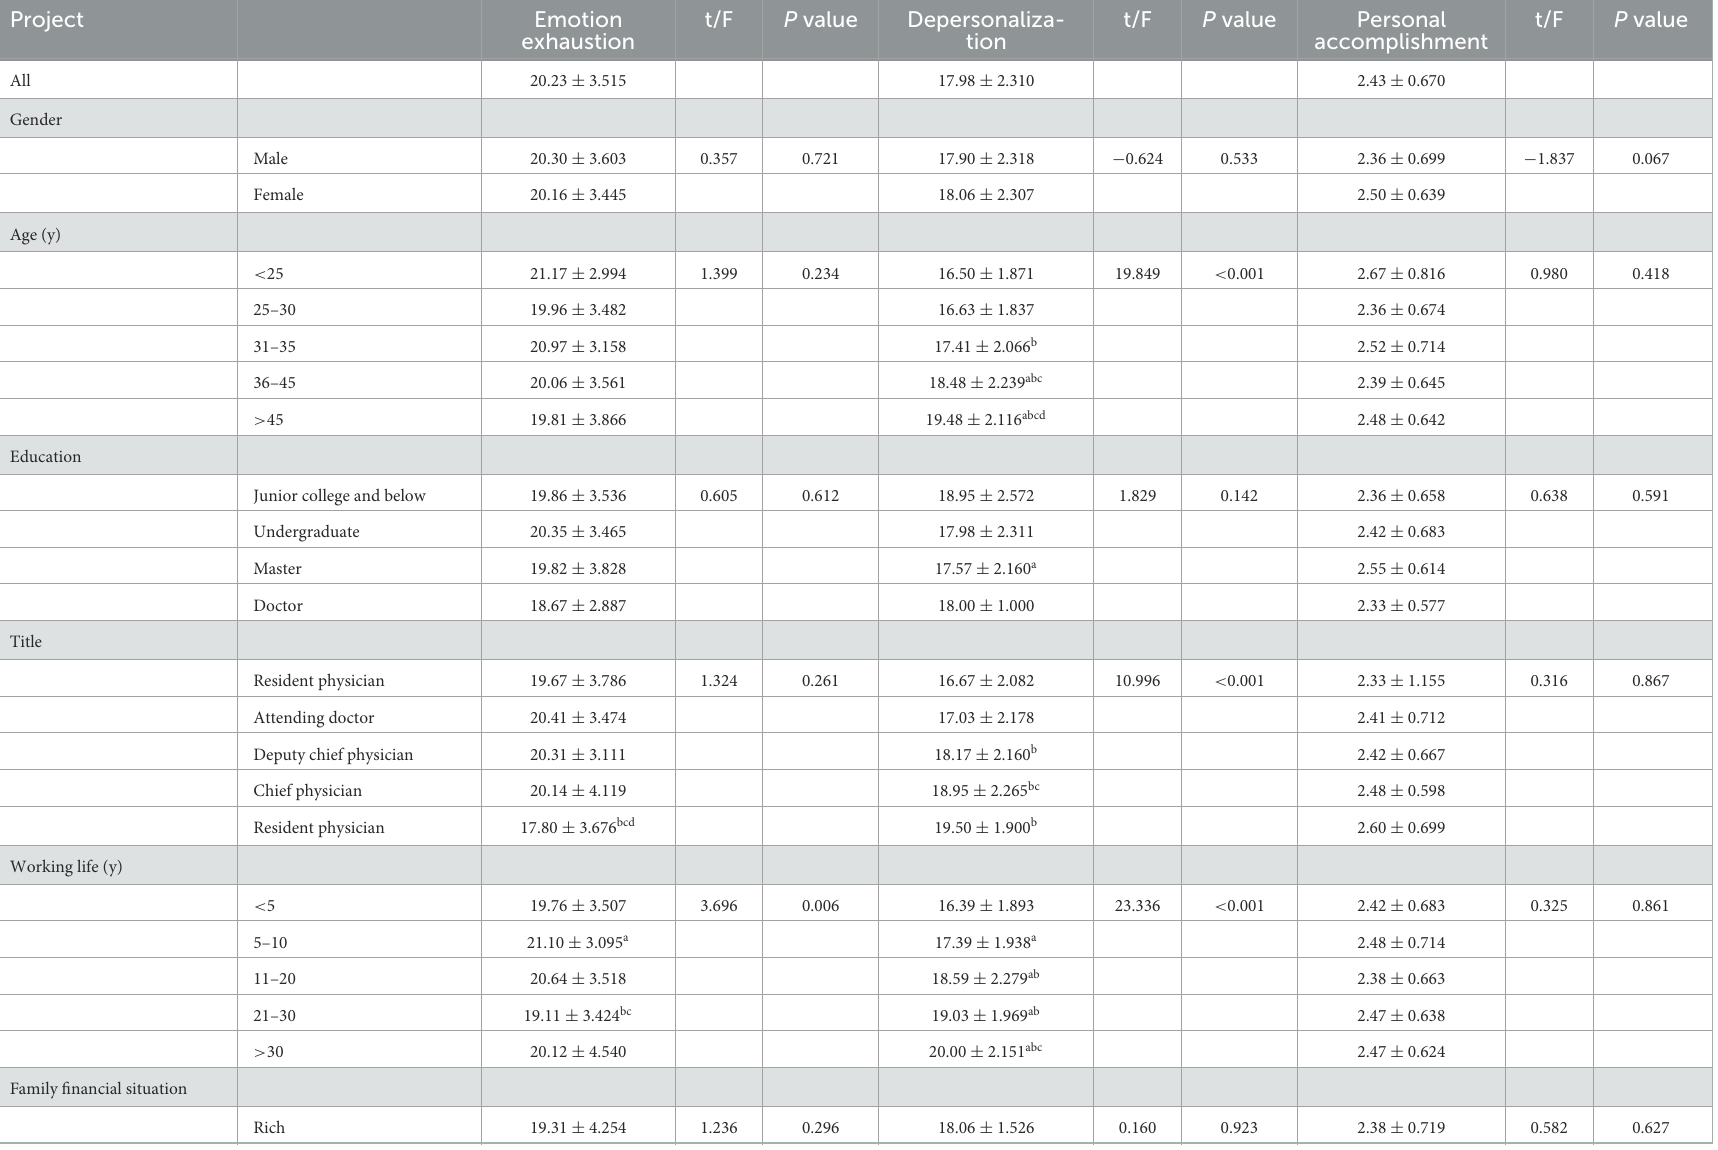
TABLE 2 Score of burnout ( ¯ x ±